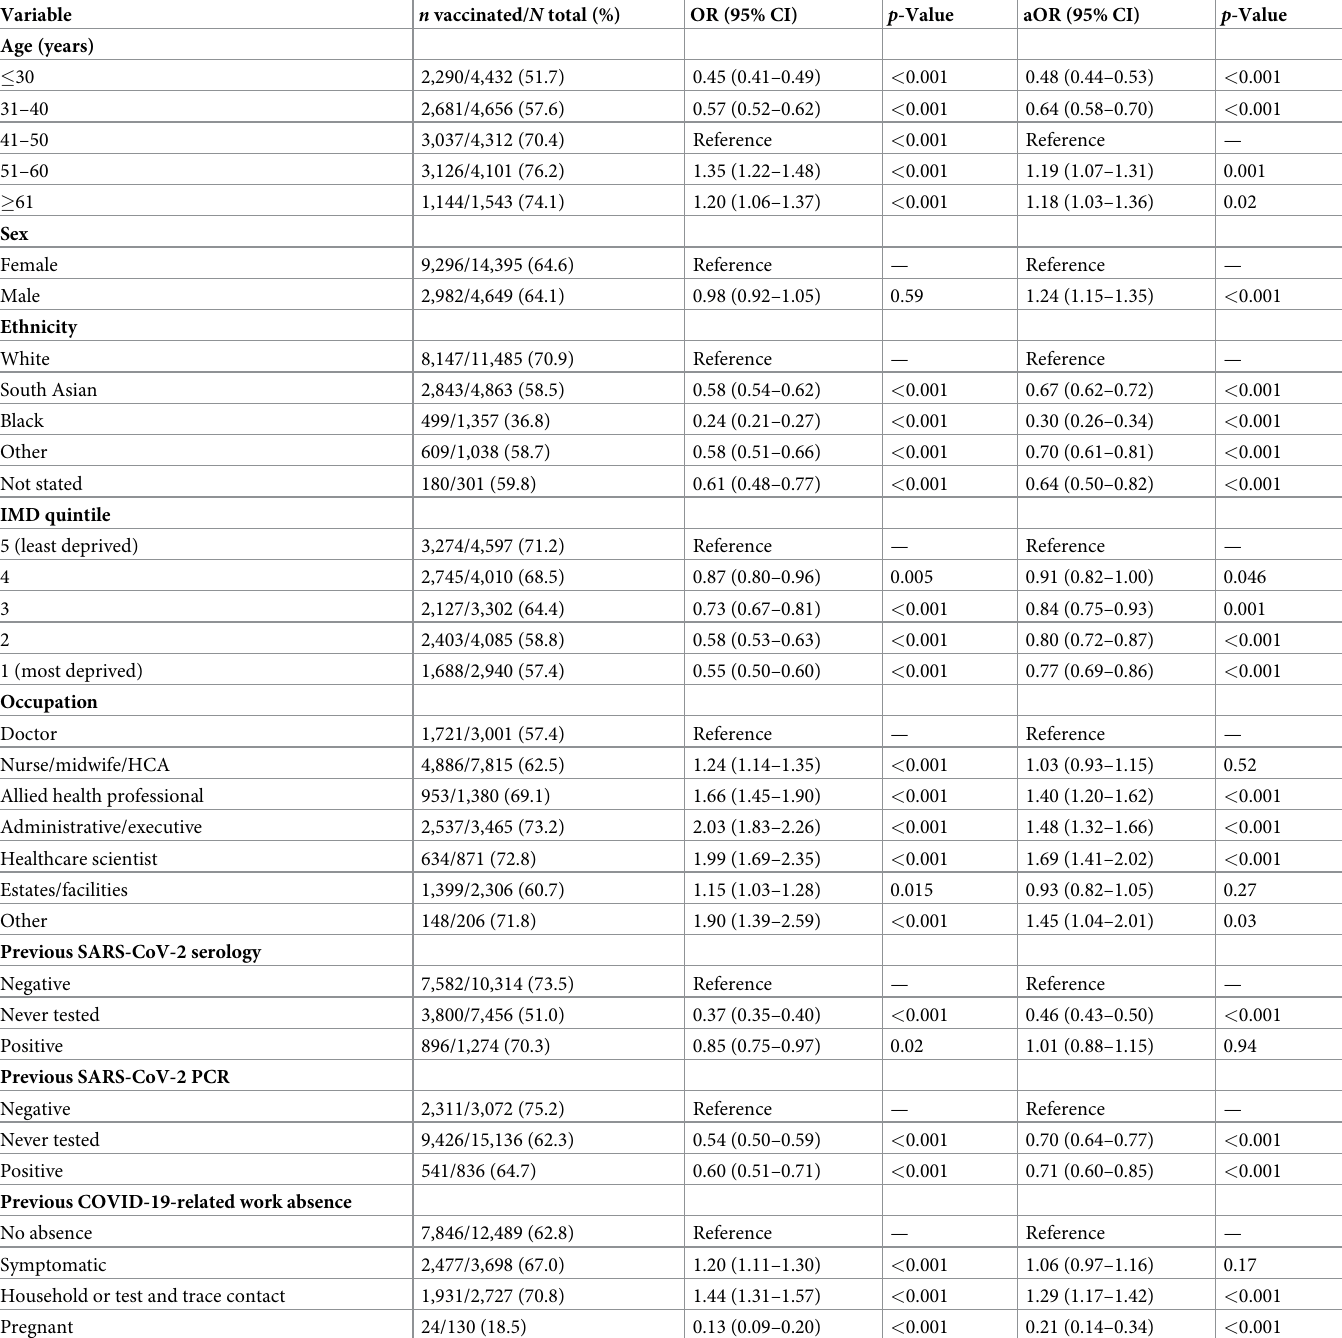
Table 2. Univariable and multivariable analysis of factors associated with SARS-CoV-2 vaccine uptake.